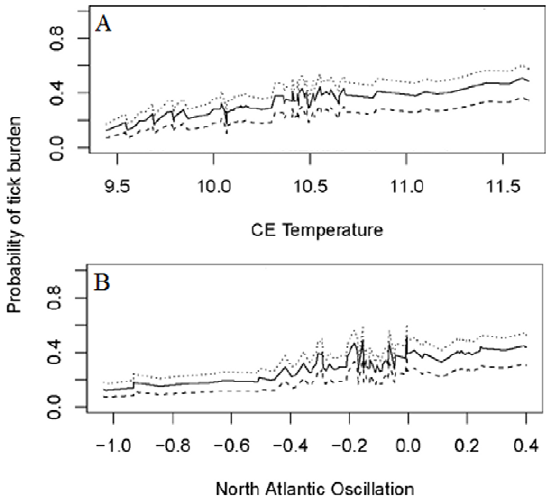
Figure 2. Abiotic impact on tick prevalence. Probability plot for a model of the association between tick prevalence and the explanatory variables A) Central England Temperature for the 12 month period preceding host death, B) North Atlantic Oscillation for the 12 month period preceding death for each host age class: Dotted line = juvenile hosts; Solid line = Adult hosts; Dashed line = Sub-adult hosts.